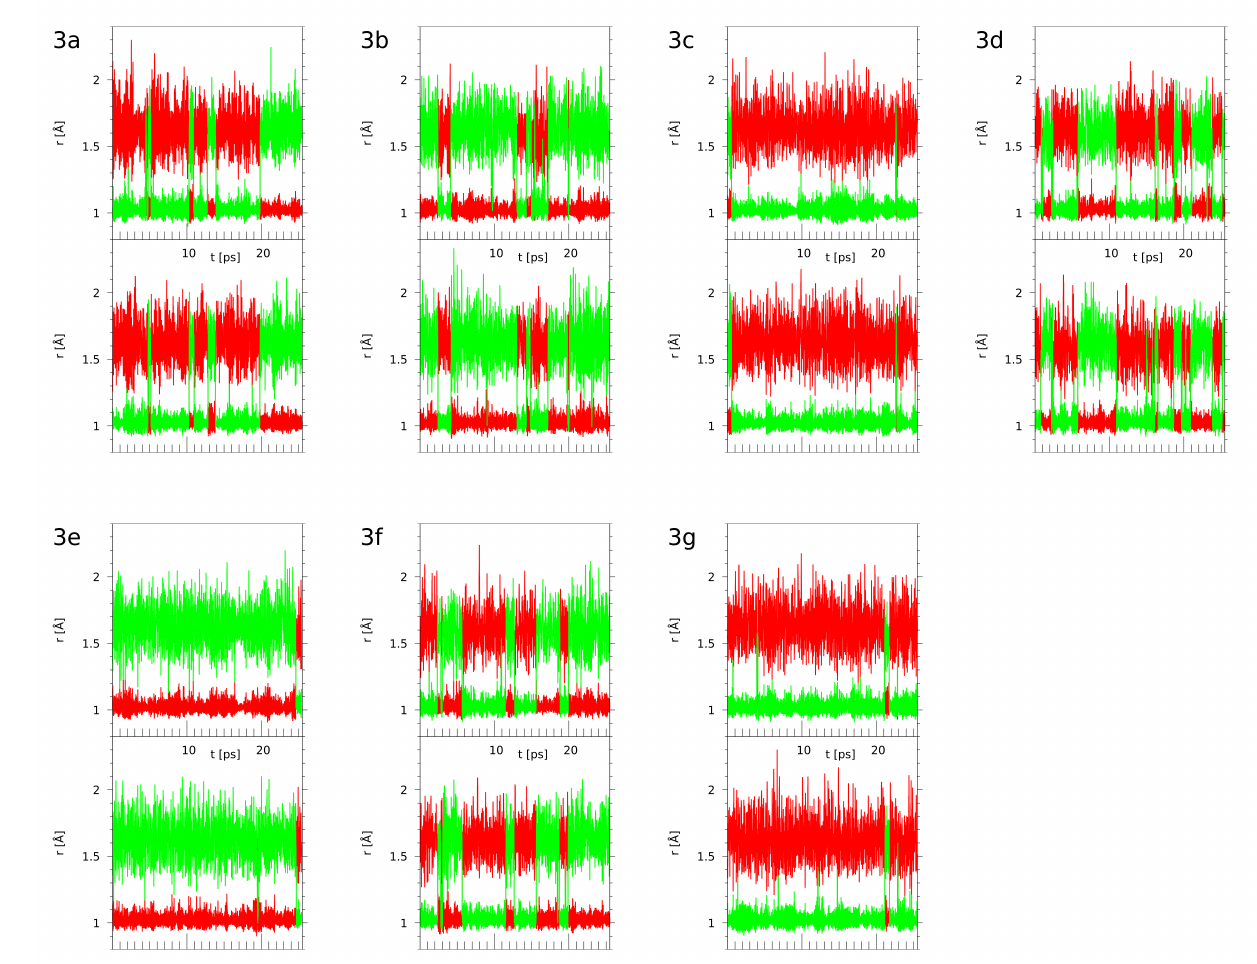
Figure 8. Time evolution of the O-H distances in the hydrogen bridges—CPMD simulation results for the compounds of group 3 . Red lines—donor-proton (O 1 -H 1 or O 2 -H 2 ) distances, green lines—acceptor-proton (H 1 -O 3 or H 2 -O 4 ) distances according to the starting structures drawn in Figure 1. For each compound, the upper part of its graph corresponds to the O 1 -H 1 -O 3 bridge and the lower part to the O 2 -H 2 -O 4